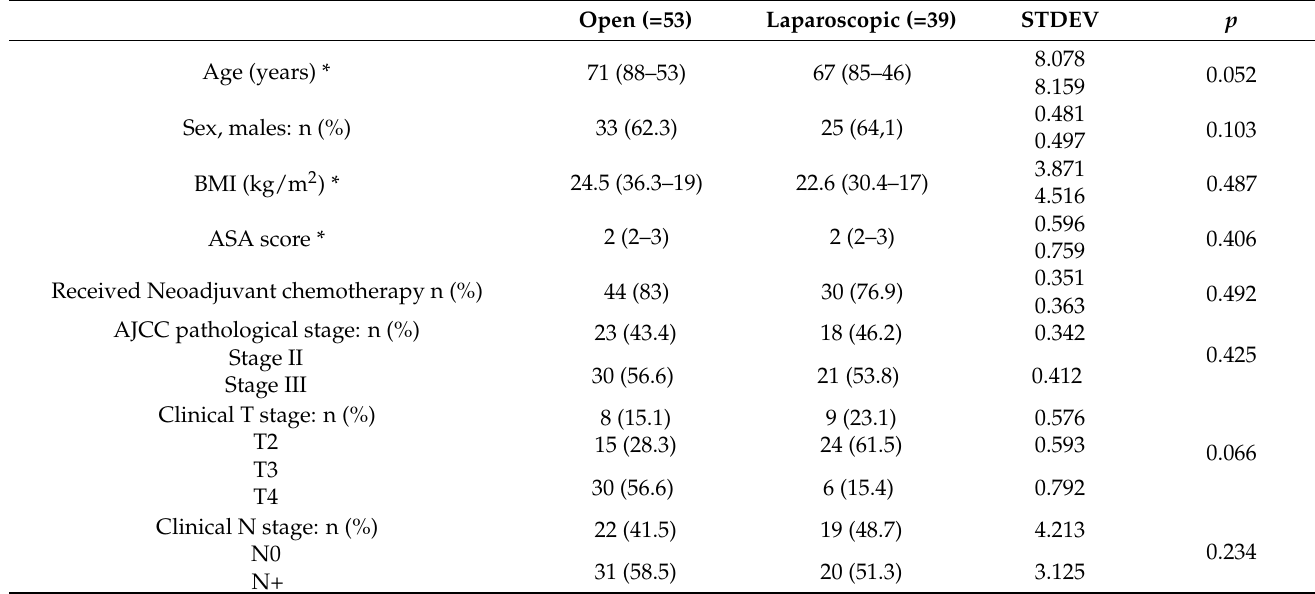
Table 1. Baseline characteristics of the population